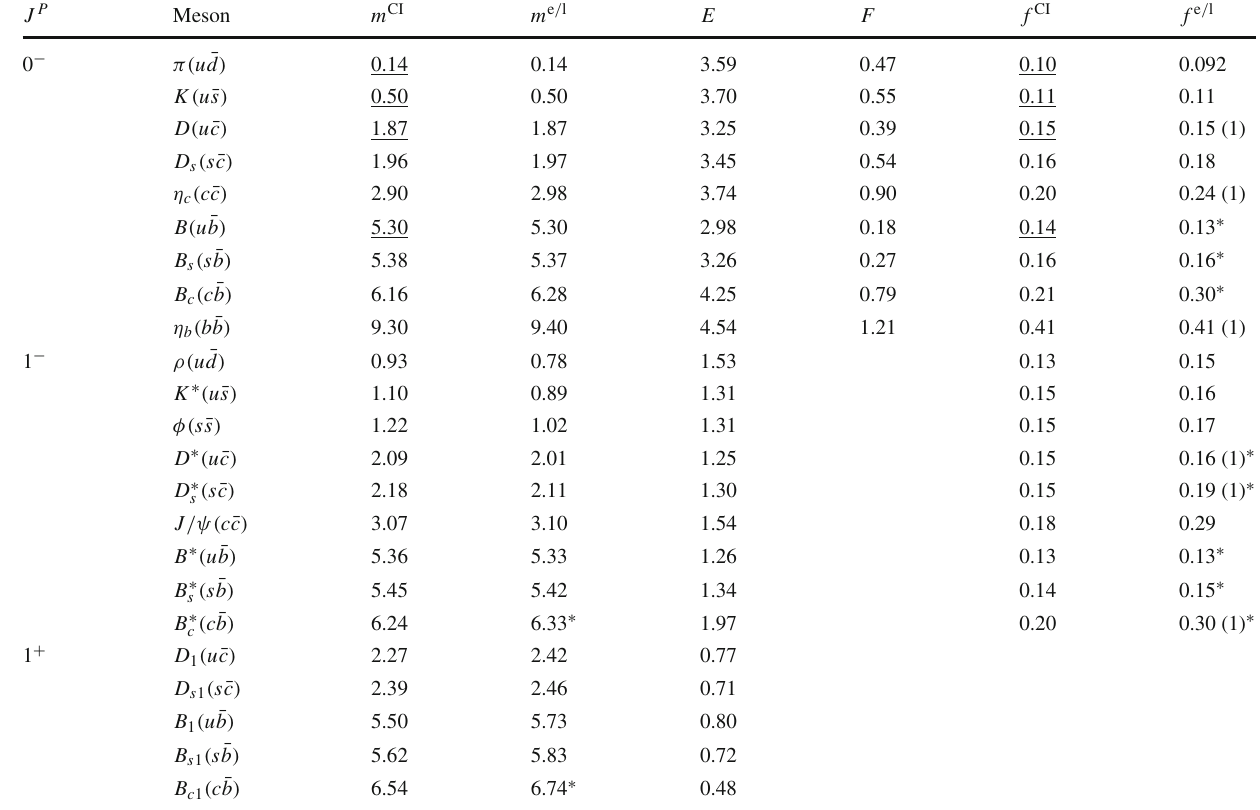
Table 3 Calculated masses (column 1), Bethe-Salpeter amplitudes (columns 3 and 4), and decay constants (column 5) for a representa- tive selection of mesons. Measured masses (column 2) from Ref. [70]; entries marked by “ ∗ ” in this column from Ref. [100]. Leptonic decay